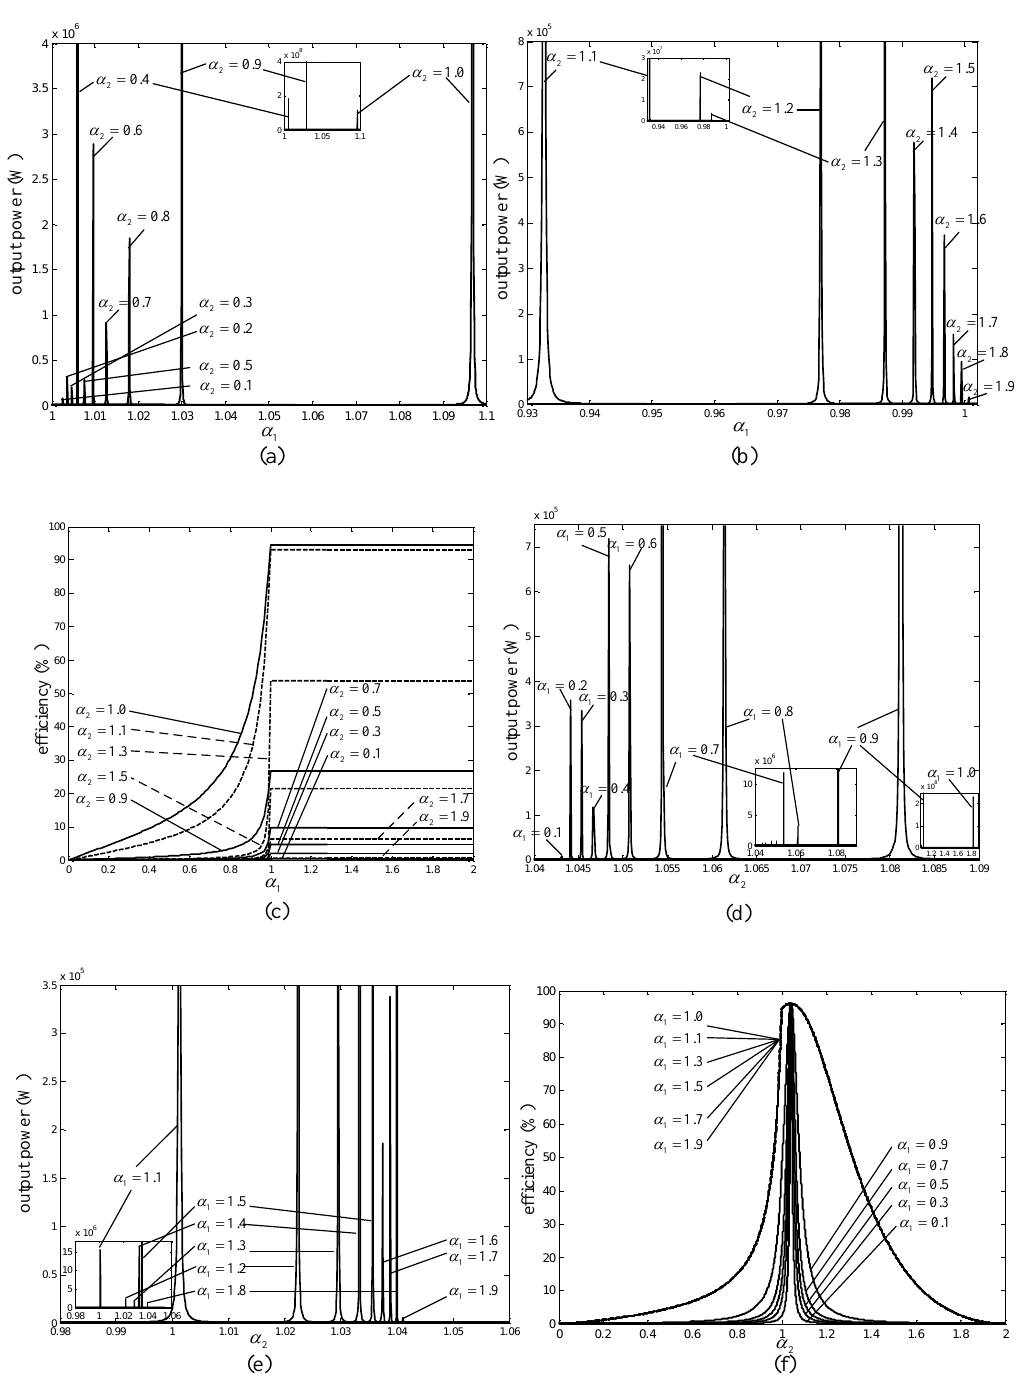
Figure 3. Theoretical curves of output power and transmission efficiency as a function of fractional order ( α 1 , α 2 ) when β = 1: ( a ) Output power versus α 1 when 0 < α 2 ≤ 1 and β = 1; ( b ) Output power versus α 1 when 1 < α 2 < 2 and β = 1; ( c ) Transmission efficiency versus α 1 when 0 < α 2 < 2 and β = 1; ( d ) Output power versus α 2 when 0 < α 1 ≤ 1 and β = 1; ( e ) Output power versus α 2 when 1 < α 1 < 2 and β = 1; ( f ) Transmission efficiency versus α 2 when 0 < α 1 < 2 and β = 1.